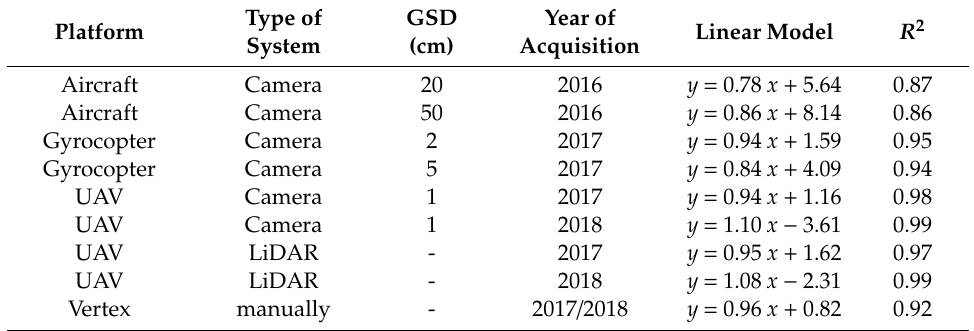
Table 4. Overview of the linear models for estimating tree height ( y = tree height by measuring tape, x = tree height by remote sensing).